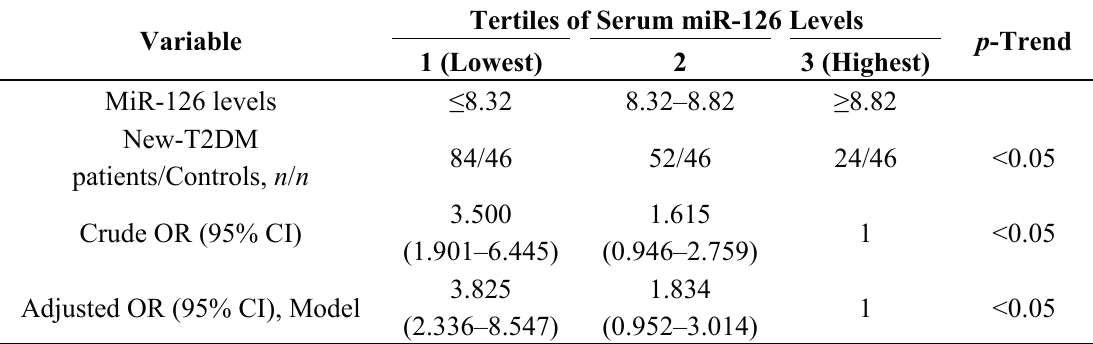
Table 3. Odds ratios (95% CI) for new-T2DM, by tertiles of circulating miR-126